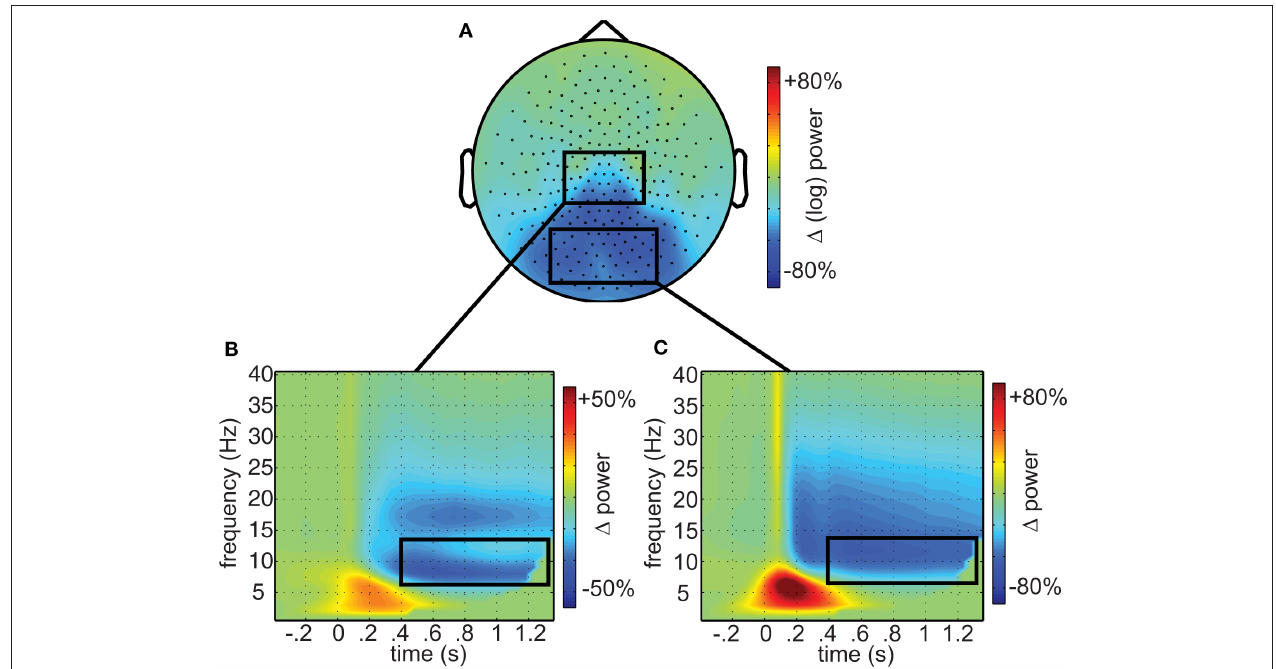
FiGurE 2 | Oscillatory responses to visual stimuli. (A) The topographic representation of alpha (7–14 Hz) suppression in response to visual stimuli (0.5–1.35 s). (B) Time–frequency representations of central and (C) occipital sensors, respectively, as identified by the boxes in (A) . Time–frequency window of interest (0.4–1.35